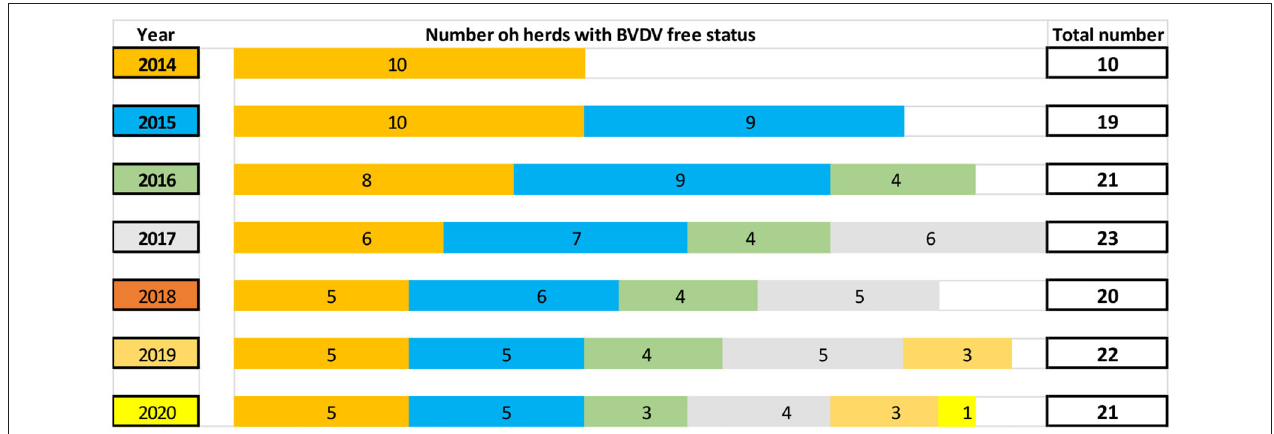
FIGURE 2 | The schematic presentation of number of herds with official BVDV free status between 2014 and 2020. The same colour represents identical herds started with BVDV free status in the same year.